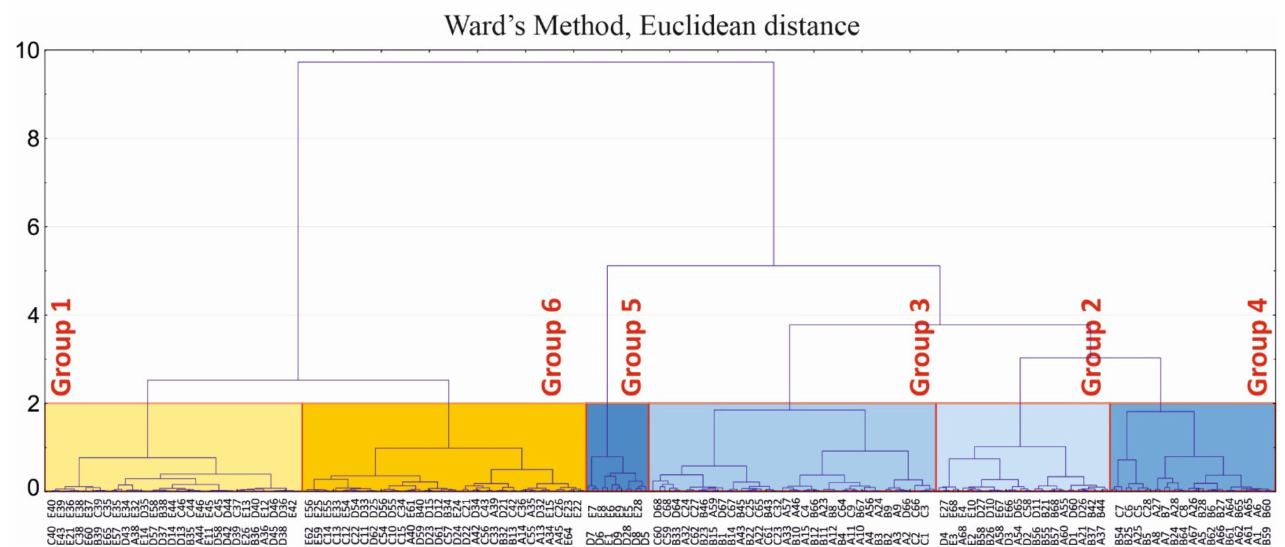
Figure 6. Land cover grouping based on the percentage shares of the individual classes via cluster analysis using Ward’s method for all the years in question. Identifier format: YB, where Y—year (A—1938, B—1951, C—1973, D—1996, E—2017), B—basic field number (from 1 to